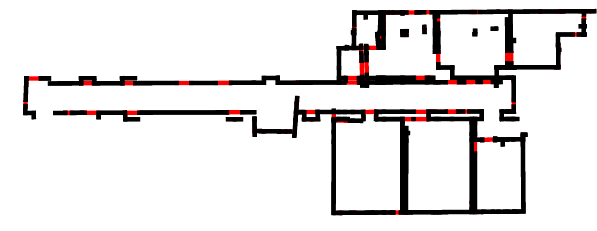
Figure 6. Wall segments (in black) and gap segments (in red) used in the face clustering step.